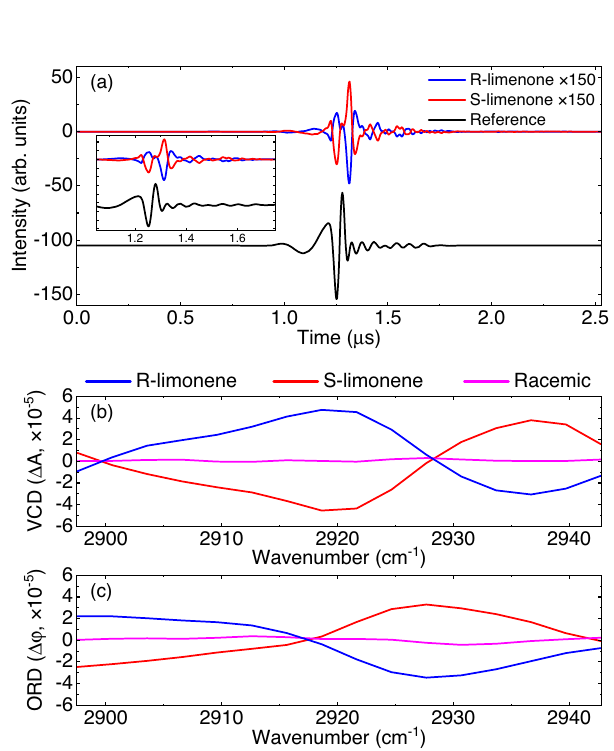
( 4 φ = π L λ ð n π (cid:2) n σ Þ . c LD(LB)( d )linesofthe Q Q( K a =3)subbranchwith N =3 – 9; e LD (LB) lines of the Q Q ( K a =5) subbranch with N =5 − 13 ( f ). The dashed lines below is the simulated results.